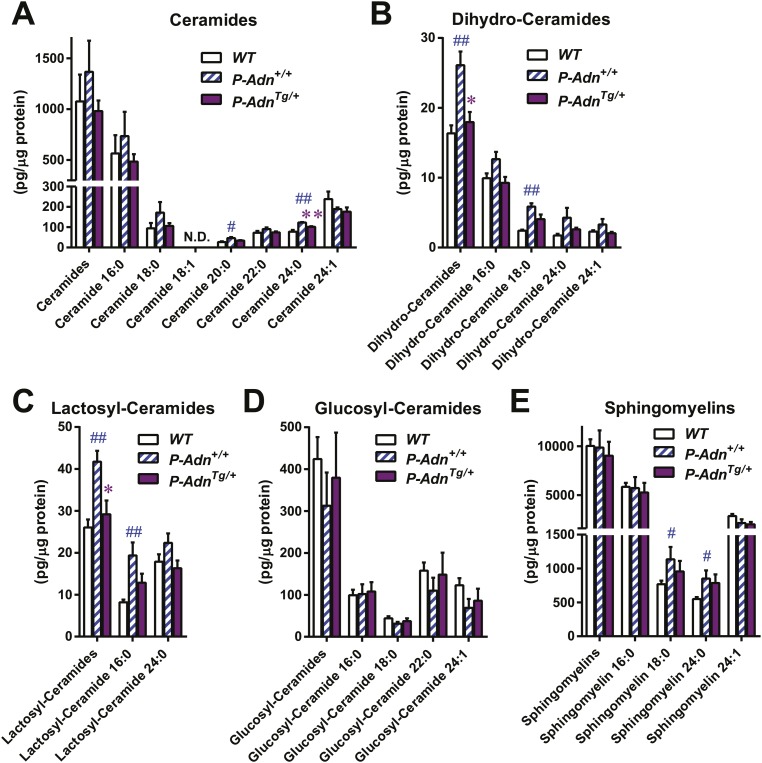
Adiponectin reduces lipotoxic sphingolipids in regenerating PANIC-ATTAC islets.Sphingolipids were assayed by mass spectrometry in pancreatic islets isolated from mice 5 weeks after initial dimerizer treatment and normalized against protein content of islet samples. n = 3–5 samples per genotype. Sphingolipid species are categorized as (A) ceramides, (B) dihydro-ceramides, (C) lactosyl-ceramides, (D) glucosyl-ceramides, and (E) sphingomyelins. In every panel, the first group of columns from the left represents the sums of all species combined. Data are presented as the mean ± SEM. *p < 0.05, **p < 0.01 for P-AdnTg/+ vs P-Adn+/+. ##p < 0.01 for P-Adn+/+ vs WT. N.D.: not detected.